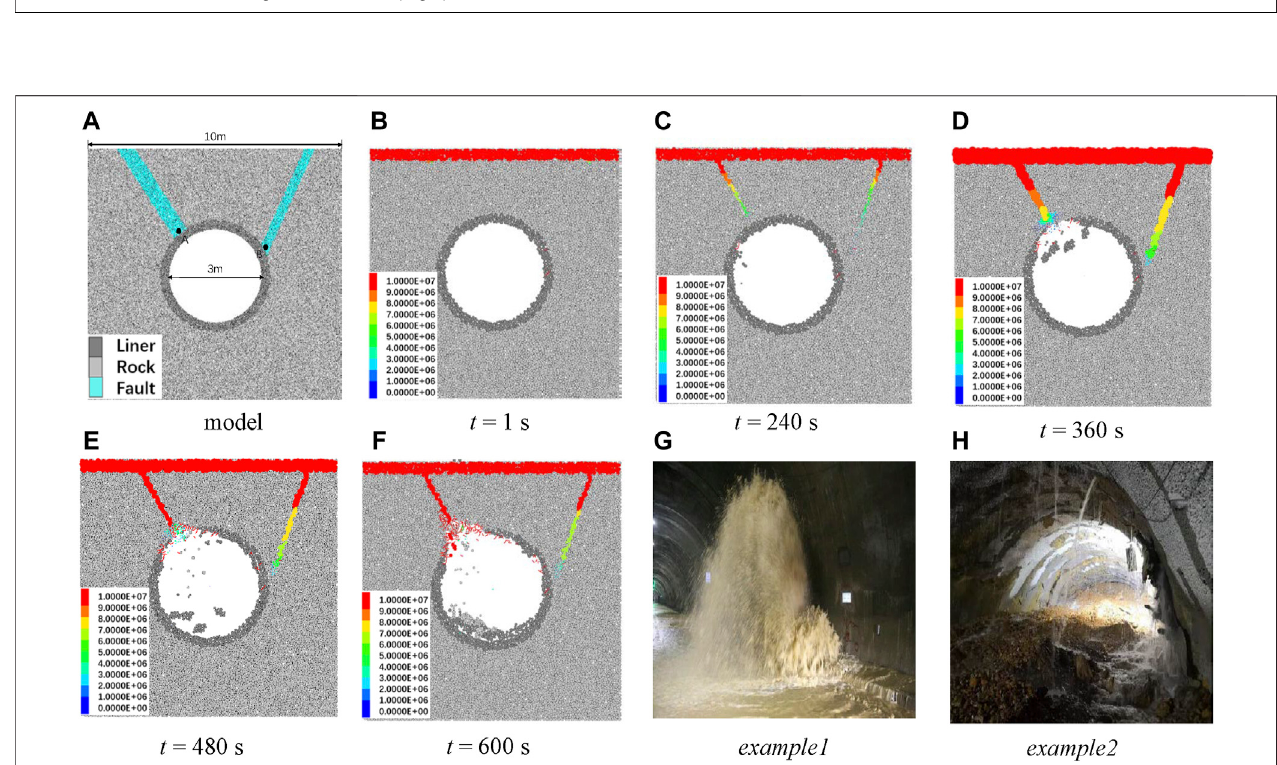
FIGURE 4 | Damage and seepage pressure distribution of the tunnel at different times under high water pressure. (A) is the tunnel model diagram, (B – F) is the diagram of tunnel seepage pressure, deformation and failure at different times, (G) and (H) are seepage failure diagrams in practical engineering.